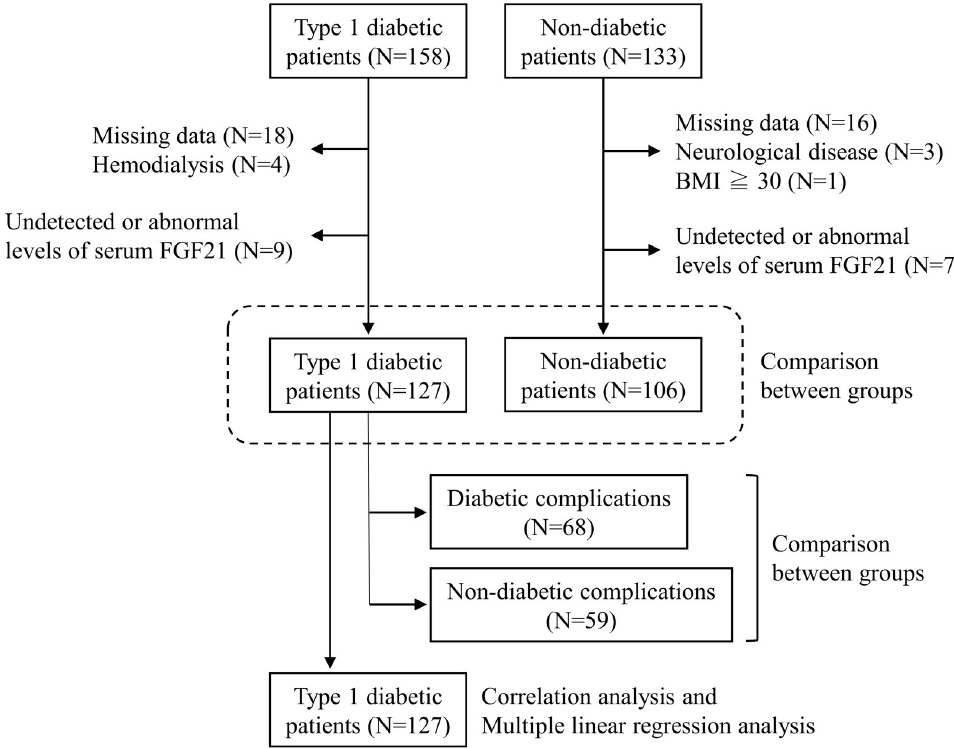
Fig 1. Flow diagram of participants in the cross-sectional